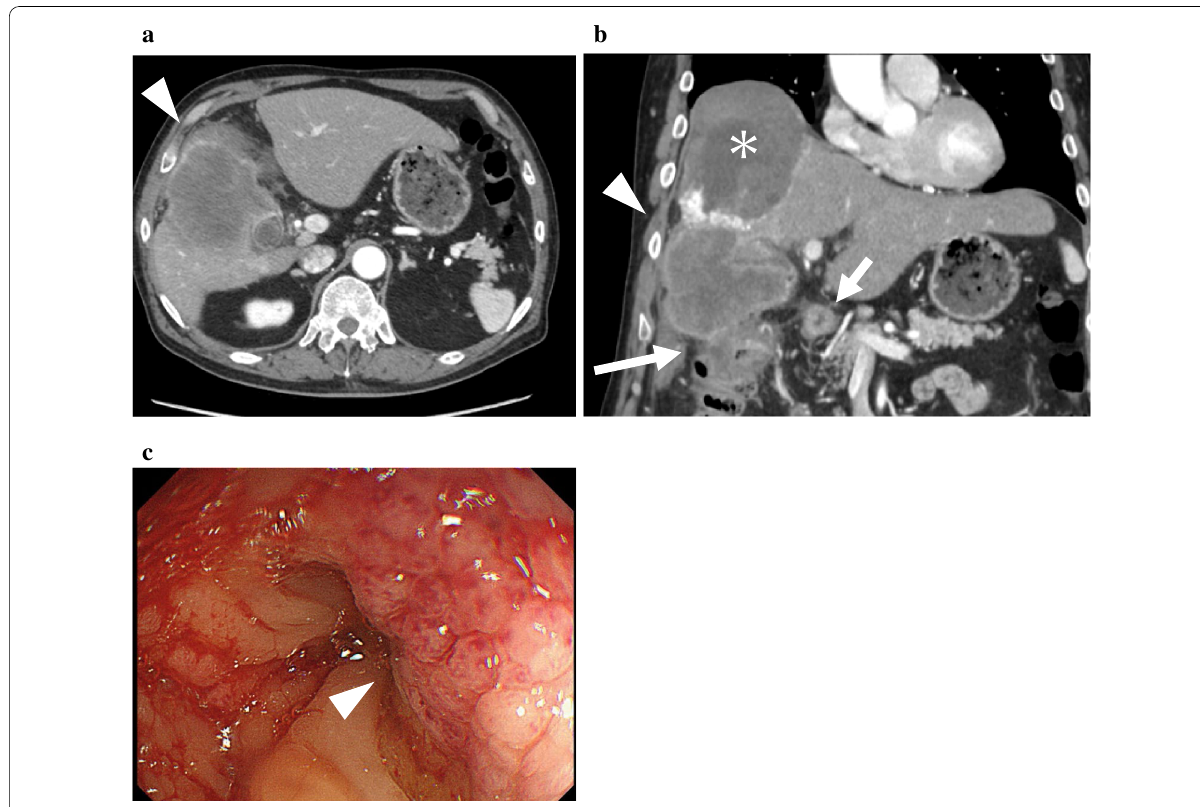
Fig. 1 Preoperative imaging findings. a Preoperative abdominal computed tomography scan. Axial view (left) and coronal view (right) showed an enlarged low-attenuation mass that was 80 mm in diameter. The mass involved the S5 segment of the liver (arrowhead) and the hepatic flexure of the transverse colon (large arrow). A nodule was observed in the transverse mesocolon (small arrow). * indicates cavernous hemangioma. b Preoperative colonoscopy. An elevated lesion was detected (arrowhead) on the transverse colon, which was a result of compression from the